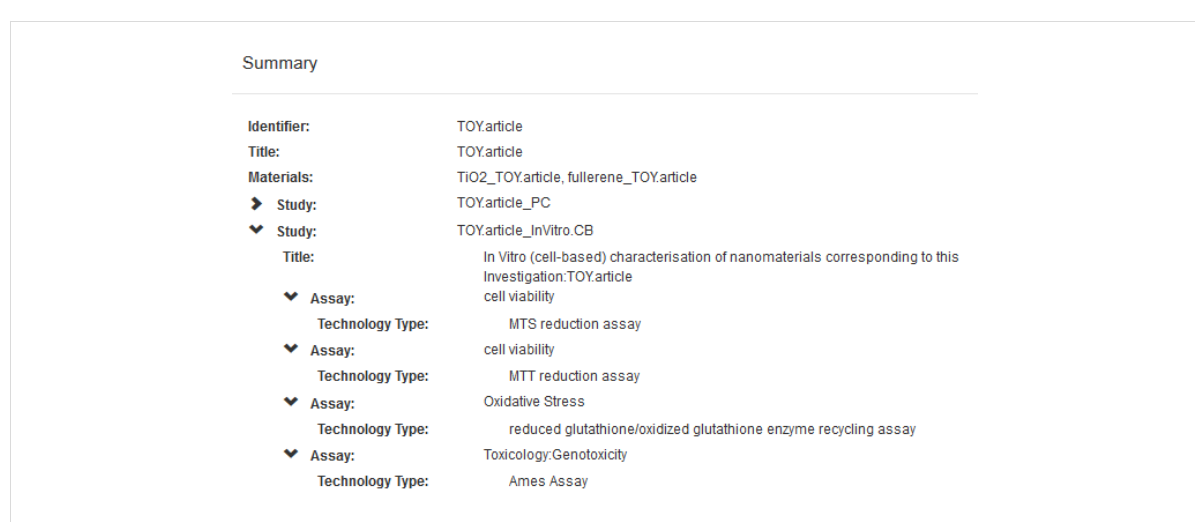
Figure 5: A summary of the in vitro cell-based assay toy data in the “Toy Dataset” (Supporting Information File 3) generated via the nanoDMS system. This summary can be generated via selecting the applicable dataset entry under the "Browse" menu of the nanoDMS